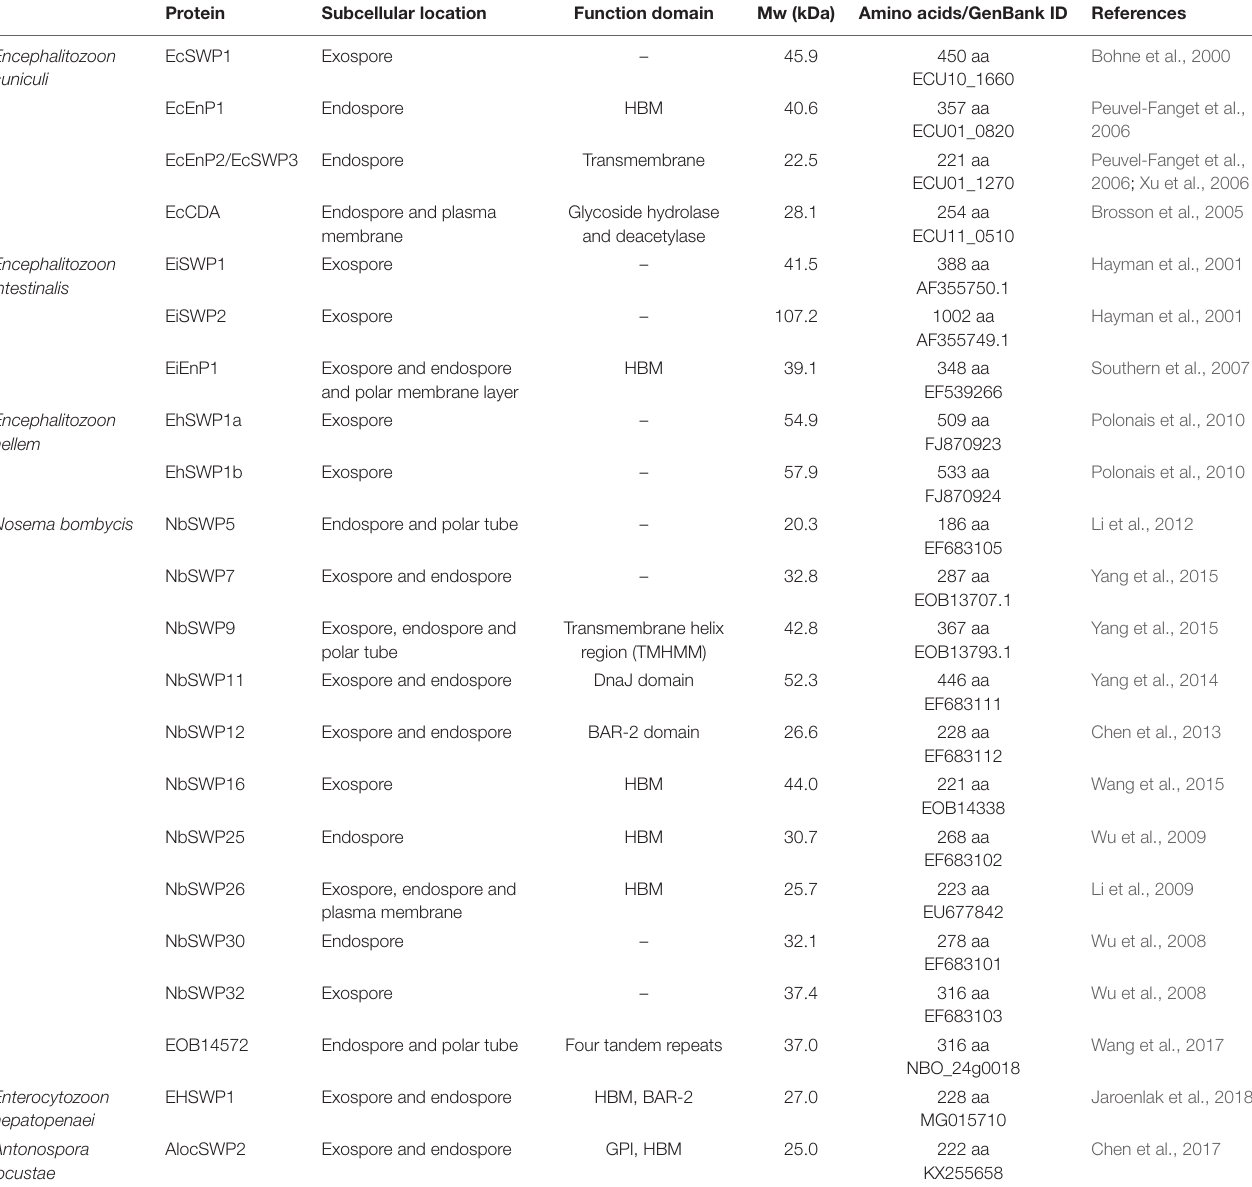
TABLE 1 | The identified spore wall proteins of Microsporidia. Protein Subcellular location Function